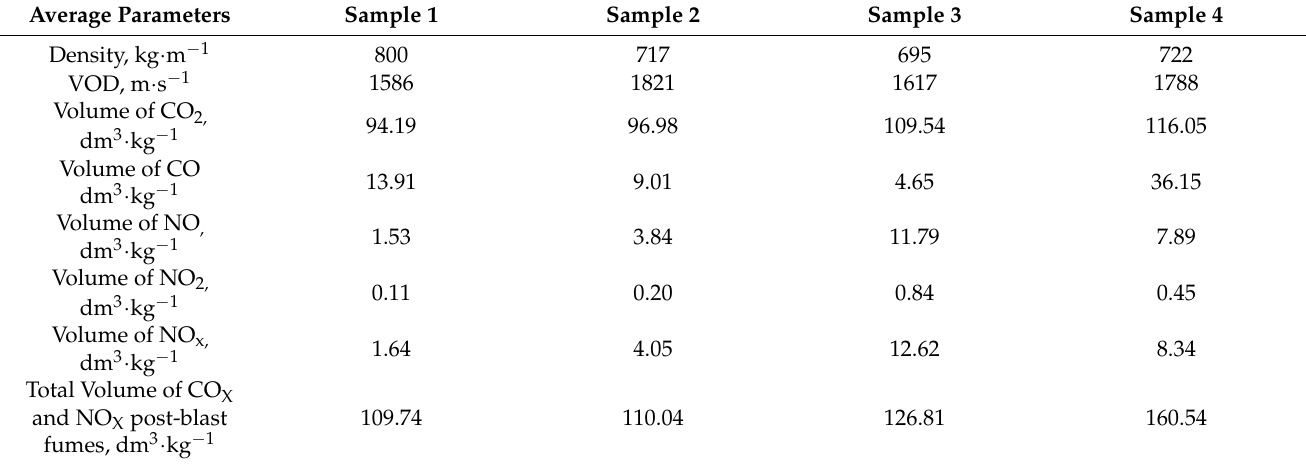
Table 3. In-situ properties of non-ideal explosives with a microstructure charcoal enhancer of − 1.18 mm grain. Average Parameters